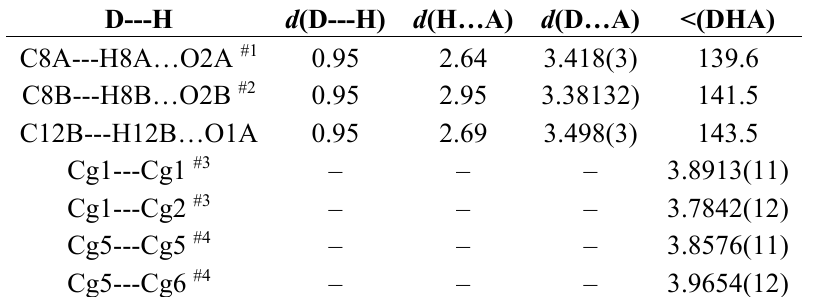
Table 2. Weak Intermolecular Interactions for (I) C 16 H 11 NO 2 , (Å and